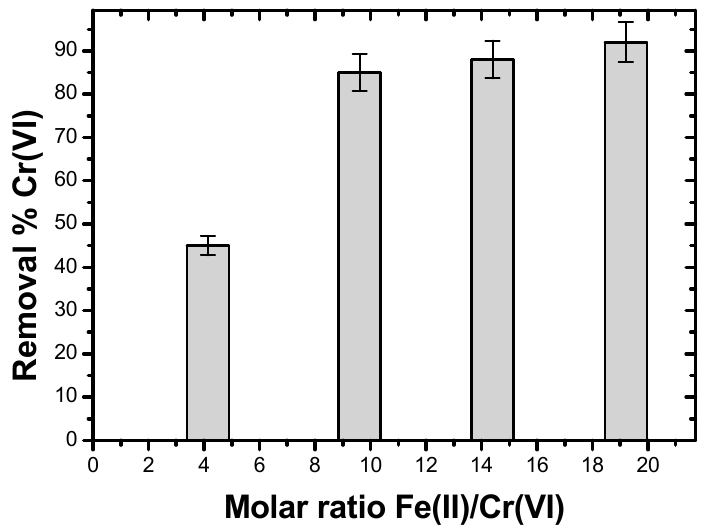
Figure 2. Removal of Cr(VI) as reated to the molar ratio of ferrous iron to hexavalent chromium. Experimental conditions: Cr(VI) initial concentration: 50 µ g / L, Fe(II) doses: 0.25, 0.5, 0.75, and 1 mg / L, Experimental conditions: Cr(VI) initial concentration: 50 μ g/L, Fe(II) doses: 0.25, 0.5, 0.75, and 1 linear velocity: 8 m / h, value of pH: mg/L, linear velocity: 8 m/h, value of pH: 7.3.